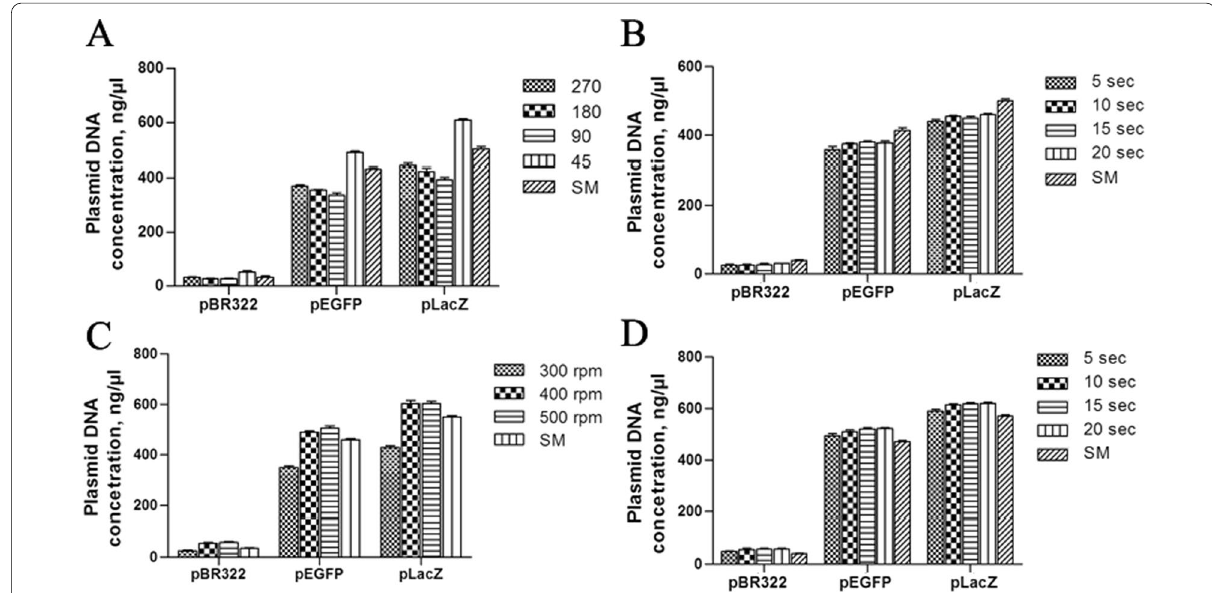
Fig. 2 Admixing efficiency of solutions performed by rotor oscillation affects the plasmid DNA yields. A Effect of oscillation amplitude of 5 s of oscillation-driving mixing in DM minipreps at an oscillation frequency of 400 rpm on plasmid yields. B Effect of time oscillation driving mixing in DM minipreps at oscillation amplitude 270° and oscillation frequency 400 rpm on plasmid yields. C Effect of oscillation frequency of 5 s of oscillation driving mixing in DM minipreps at oscillation amplitude 45° on plasmid yields. D Effect of time oscillation driving mixing at oscillation amplitude 45° and oscillation frequency 400 rpm in DM minipreps on plasmid yields. Assays were performed in triplicate, and error bars represent the standard